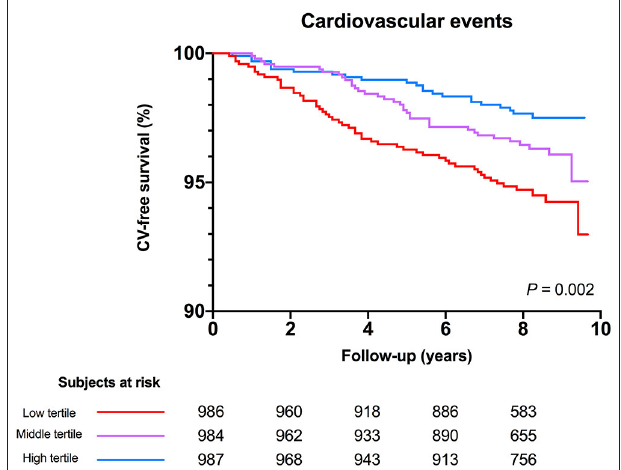
FIGURE 3 | Kaplan-Meier survival distributions demonstrating CV-disease free survival among tertiles of serum free thiols. Highest rate of CV-events occurred in the lowest tertile of serum free thiols (log-rank test, P = 0.002).